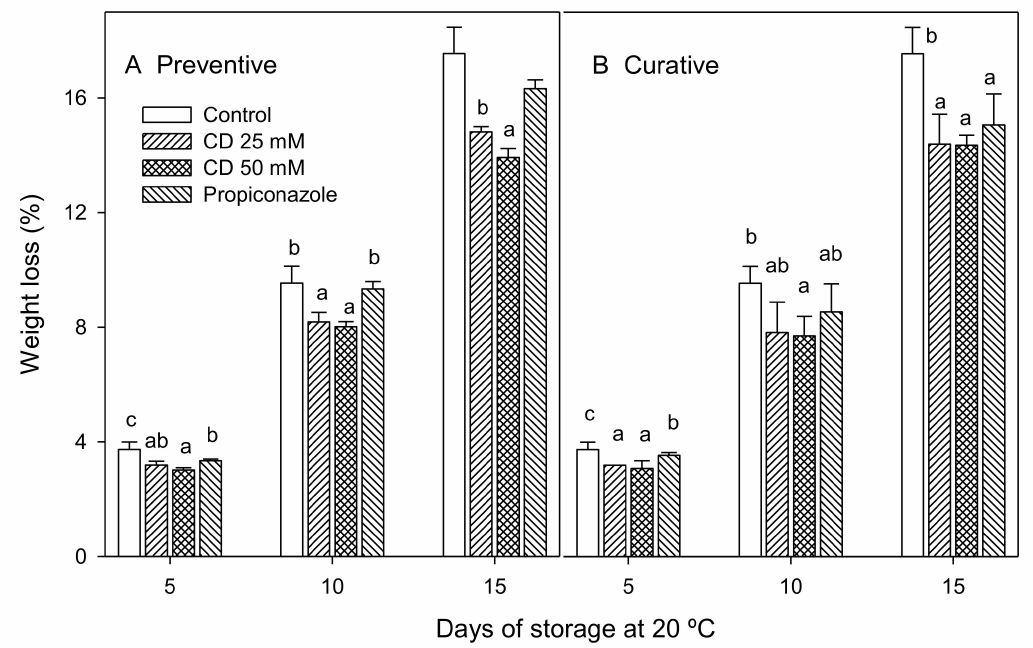
Figure 2. Weight loss (%) of “Fino 49” lemon fruit treated with 25 or 50 mM HP- β -CD-thymol or propiconazole during 15 d of storage at 20 ◦ C in preventive ( A ) and curative ( B ) experiments. Data are the mean ± SE. Di ff erent letters show significant di ff erences ( p < 0.05) among treatments, for each sampling